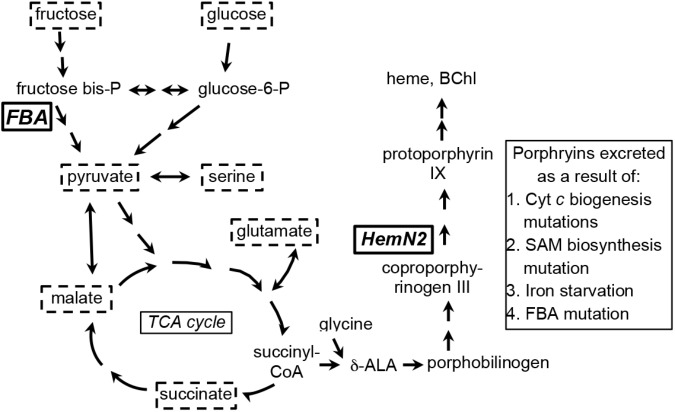
Simplified representation of porphyrin tetrapyrrole biosynthesis and metabolic pathways in Rhodobacter capsulatus relevant to the carbon substrates (enclosed in dashed boxes) used for growth of cultures in this work. Fructose is taken up by a phosphotransferase system, enters the cell as fructose-1-phosphate, and is catabolized to pyruvate through an Embden-Meyerhof-Parnas series of reactions (FBA, fructose bisphosphate aldolase). Glucose appears to be phosphorylated by glucokinase after entry into the cell, and glucose-6-phosphate is catabolized to pyruvate through an Entner–Doudoroff pathway. Fructose bisphosphate and glucose-6-phosphate can be interconverted through the sequential action of fructose 1–6 diphosphatase and phosphoglucose isomerase. Relationships between organic and amino acids are as shown. HemN2, the anaerobic coproporphyrinogen III oxidase encoded by rcc02494. The number of arrows in pathways may not necessarily correspond to the number of enzymatic reactions separating the substances shown (Eidels and Preiss, 1970; Conrad and Schlegel, 1977; Beatty and Gest, 1981a,b; Daniels et al., 1988; Biel and Biel, 1990; Wu and Saier, 1990; Goldman et al., 1997; Deshmukh et al., 2000; Dailey et al., 2017).